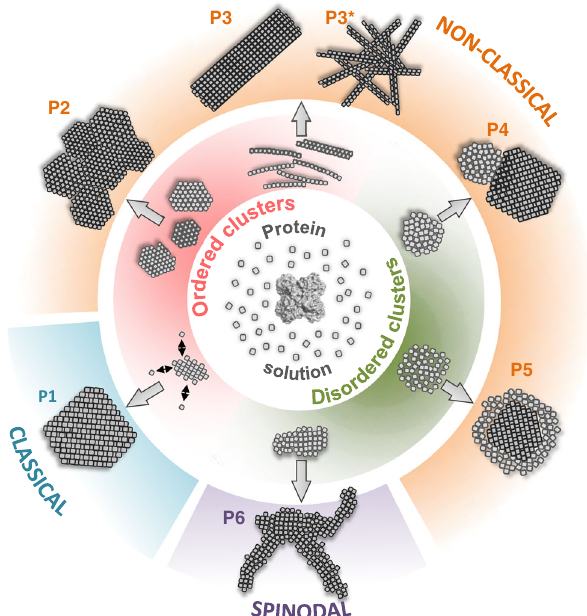
Fig. 5 Protein crystal nucleation pathways that have been experimentally observed at the nanoscale. P1: one-step nucleation solely involving crystalline clusters throughout the entire pathway (glucose isomerase I222 5 ); P2 and P3: involving oriented attachment of 2D, 3D and 1D crystalline clusters into larger ordered assemblies (glucose isomerase H32 and P2 2 2 5 ); P3*: spinodal decomposition limit of the P3 scenario leading to kinetic jamming (gel) 5 ; P4: self-seeded nucleation of crystalline clusters on the surfaces of solid, amorphous condensates (lysozyme 6 ); P5: two-step nucleation comprising initial densi fi cation into loose disordered clusters, followed by gradual local desolvation and densi fi cation into a crystalline array (ferritin 10 ); P6: aggregation in the high supersaturation limit with poorly ordered clusters 5 .